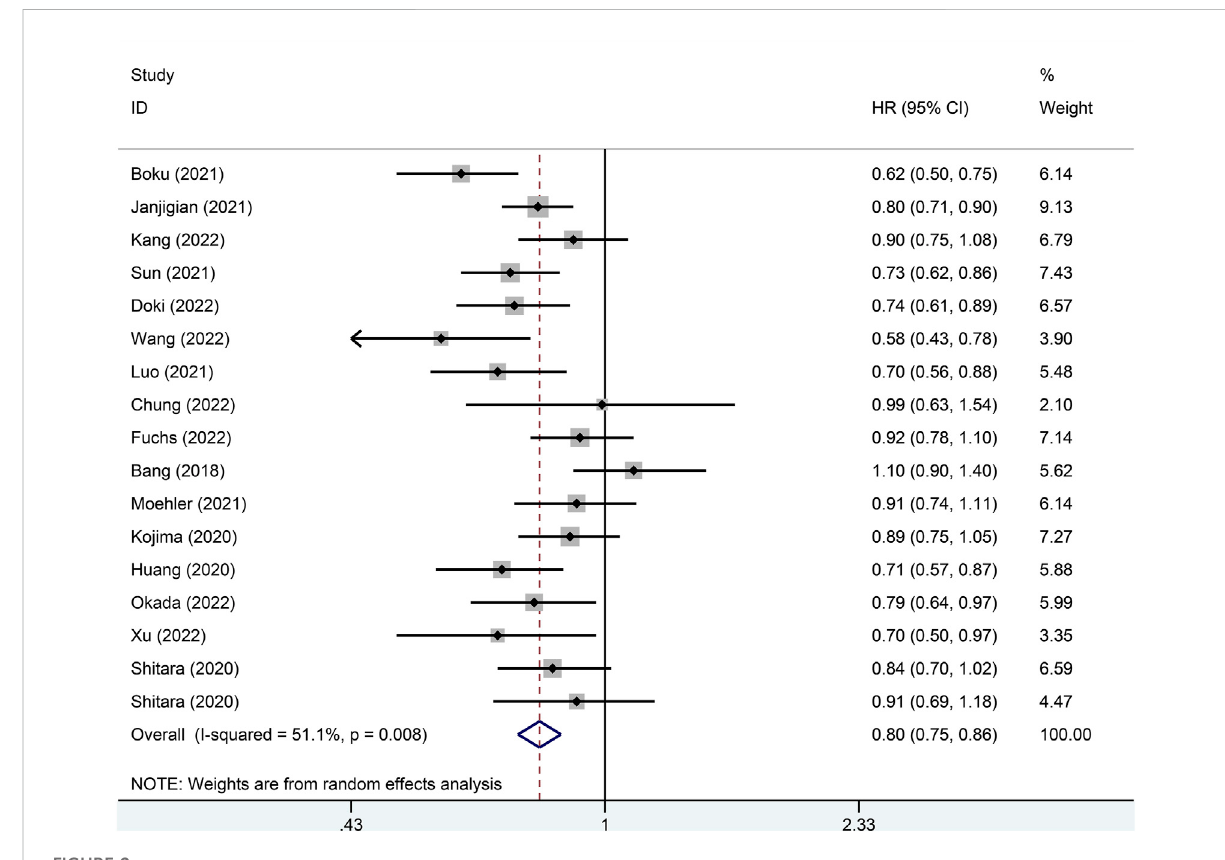
FIGURE 2 Forest plot of the p value for the overall survival in the general